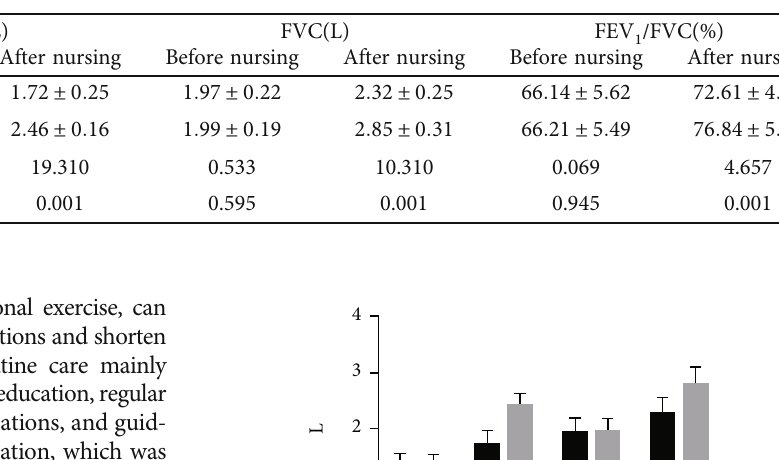
Table 3: Comparison of lung function between the two groups ( (cid:1) x ± s ).